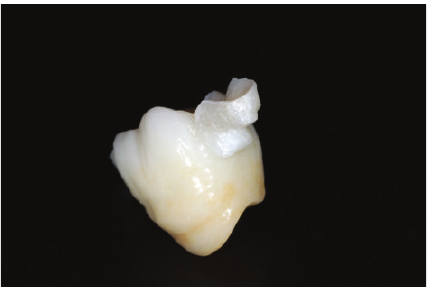
Figure 8: IRFDP conditioned for final adhesive